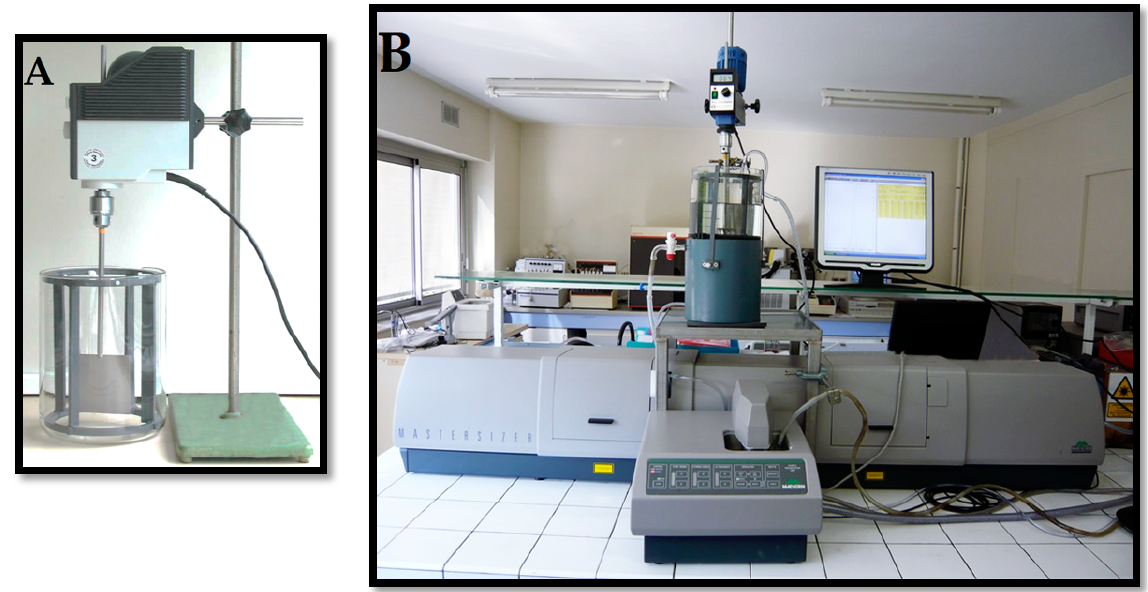
Figure 9. ( A ) photo of the flocculation reactor; ( B ) photo of the setup implemented for floc texture